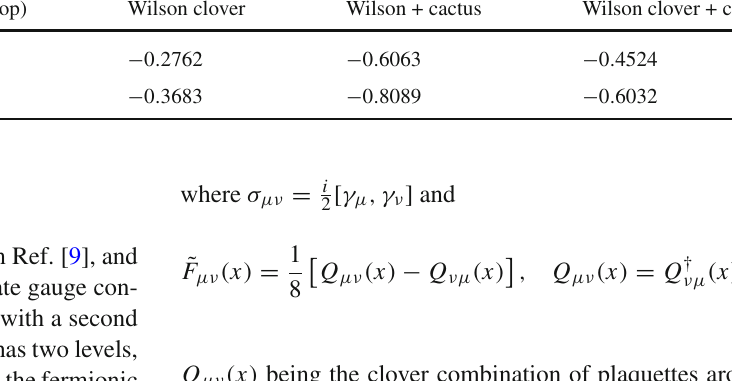
Table 2 Critical masses for different lattice actions and improvements. When not specified, the results are obtained at 1 loop. These values are to be compared with the non-perturbative results of Sect. 6 Wilson Wilson (2 loop) Wilson clover Wilson + cactus Wilson clover +